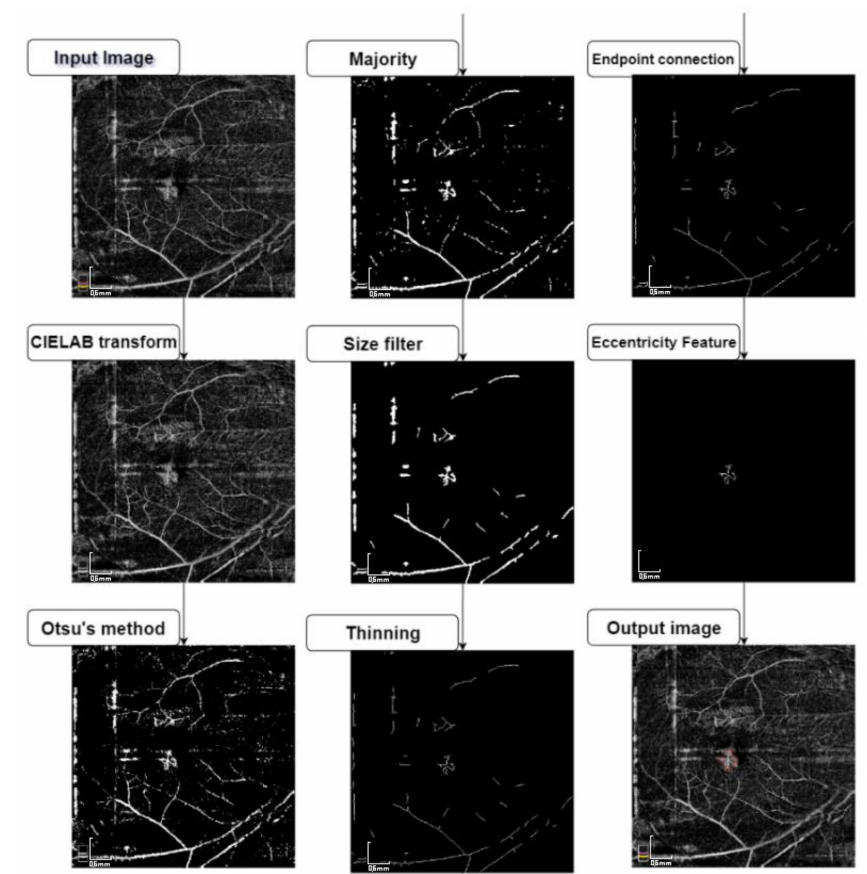
Figure 7. Schematic diagram of each step process. The original image uses the CIELAB transform to extract the L channel, removes noise after passing through Otsu’s method, Majority, and Size filter, and finally finds CNV through thinning, endpoint connection, and eccentricity feature.